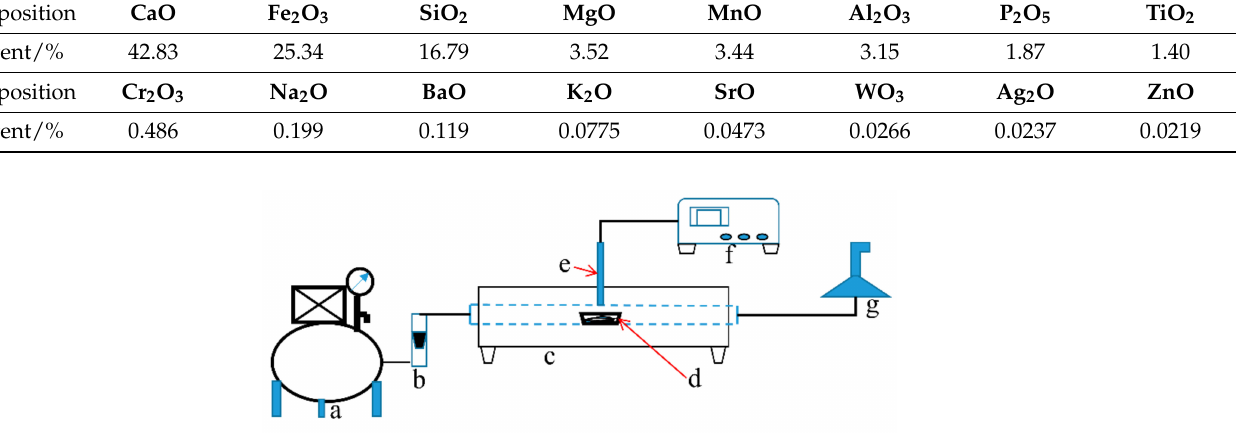
Figure 1. Schematic diagram of sulfur fixation equipment. a: Air compressor; b: Flow-meter; c: